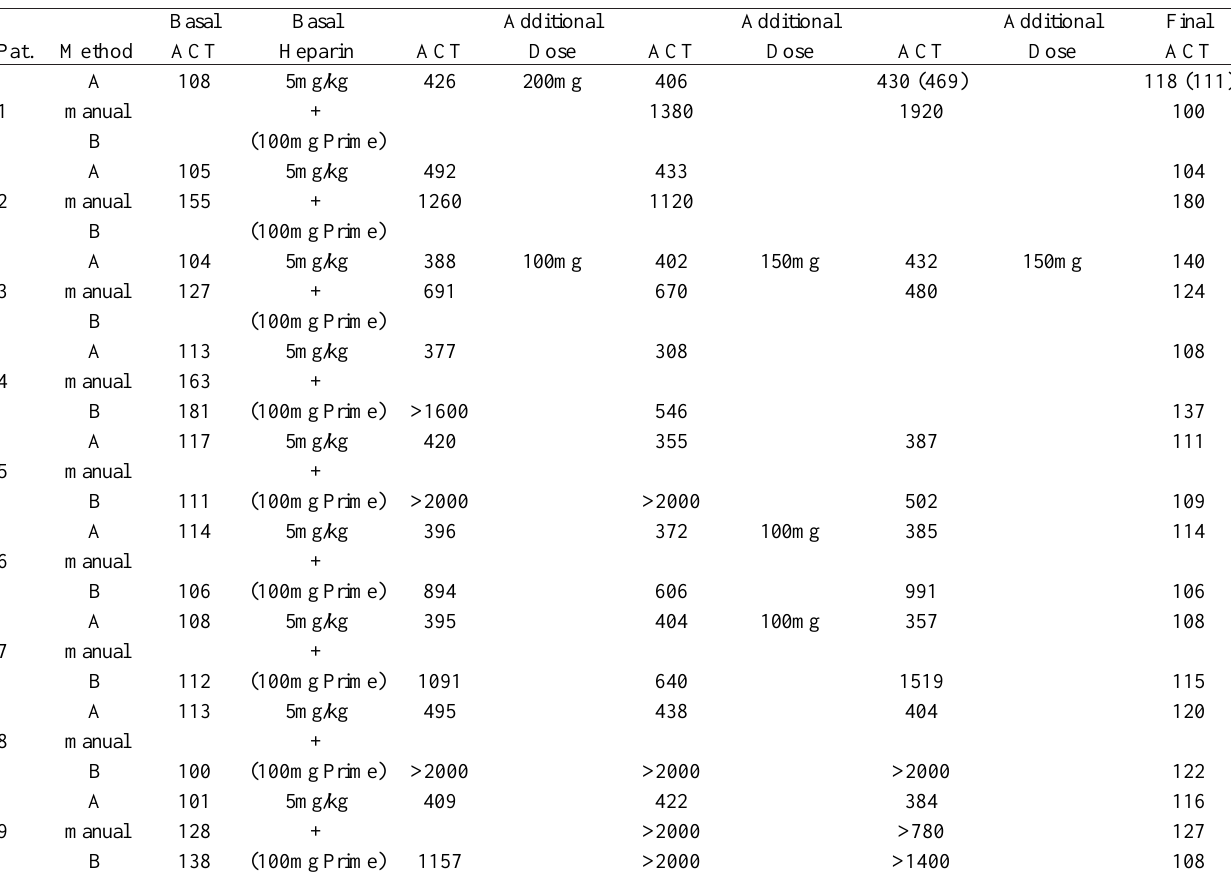
Table 1. Activated Clotting Time (ACT) and heparin dosages